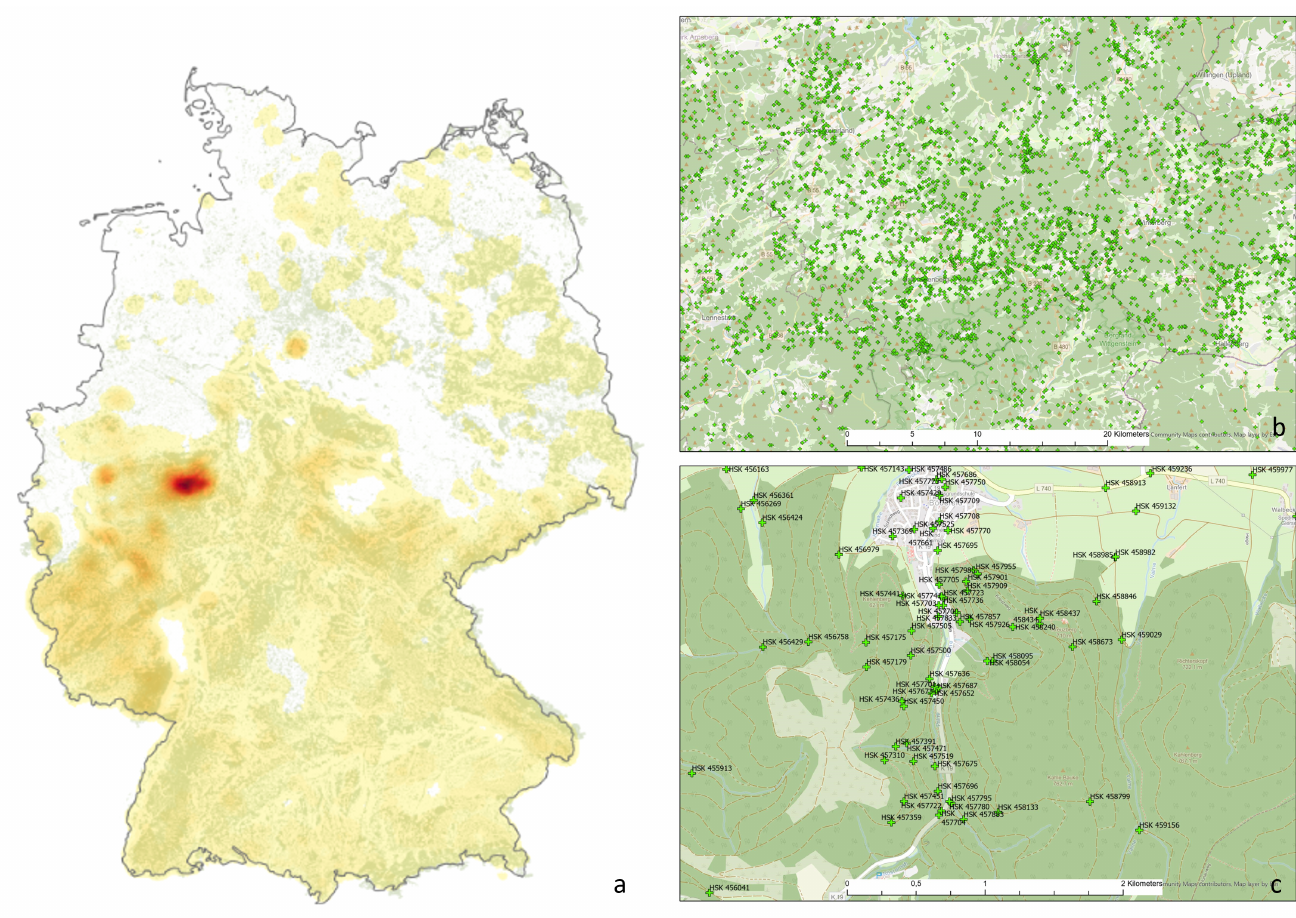
Figure 13. ( a ) Rescue point density map of Germany. ( b , c ) Map of the rescue points (green cross) as a section of the high dense area at two different